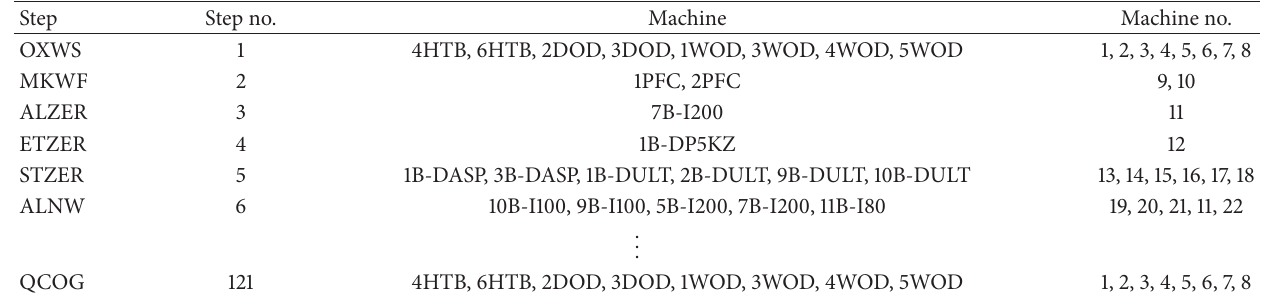
Table 3: The steps of fabricating a semiconductor